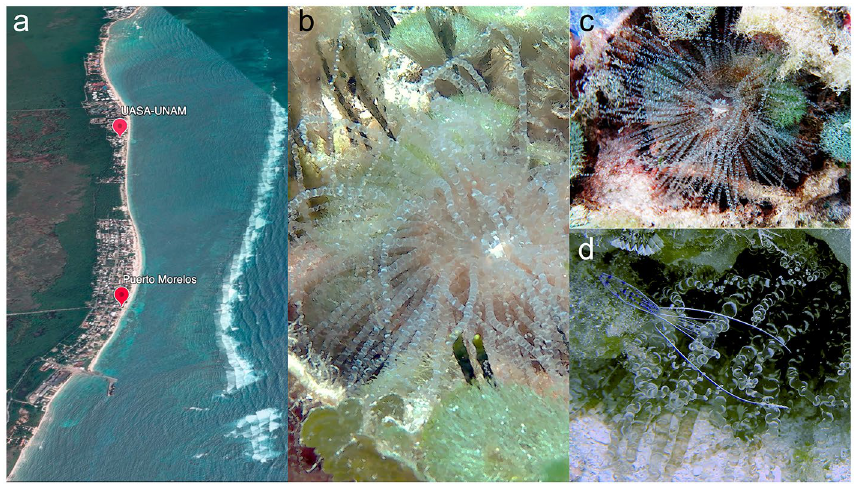
Figure 1. Sampling site location of Bartholomea annulata at the reef lagoon of Puerto Morelos, Quintana Roo. ( a ) Google Earth satellite image of Puerto Morelos Reef Lagoon, Quintana Roo, México; location points indicate Puerto Morelos town and the Unidad Académica de Sistemas Arrecifales UNAM (UASA-UNAM) (20° 50 ′ 45 ″ N 86° 52 ′ 08 ″ W and 20° 50 ′ 55 ″ N 86° 52 ′ 52 ″ W, respectively). ( b–d ) Sea anemone Bartholomea annulata is a member of family Aiptasiidae of the class Anthozoa; it is also commonly known as “corkscrew anemone”, due to spiral bands on its tentacles. Regularly is found inside crevices of rocks and coral rubble and has